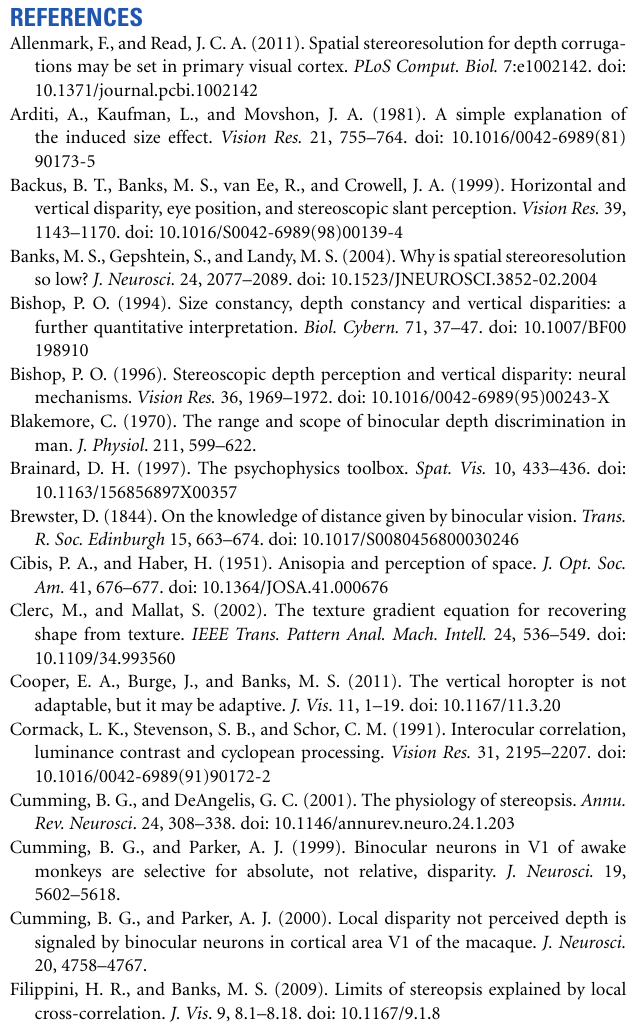
Supplementary Video 1 | Demonstration of Venetian-blind effect as a function of frequency ratio. Top: Two spatial frequency gratings are initially presented with a frequency ratio of one. The spatial frequencies of the gratings change in opposite sign until the frequency ratio is equal to 0.67. The frequencies of the gratings then converge until the ratio returns to one. Bottom: The cross correlation output is shown for each frame of the video. Green regions represent high correlation while black regions represent low correlation. Azimuth is shown in the abscissa and corresponds to azimuth in the gratings above; high correlation is computed for all disparities beyond the edge of the gratings because there are no unique features to constrain matching. The ordinate of the correlation output represents disparity and changes from crossed disparity (in front of the screen) at the bottom of the correlation output to uncrossed disparity (behind the screen) at the top of the correlation output; zero disparity is denoted by the white